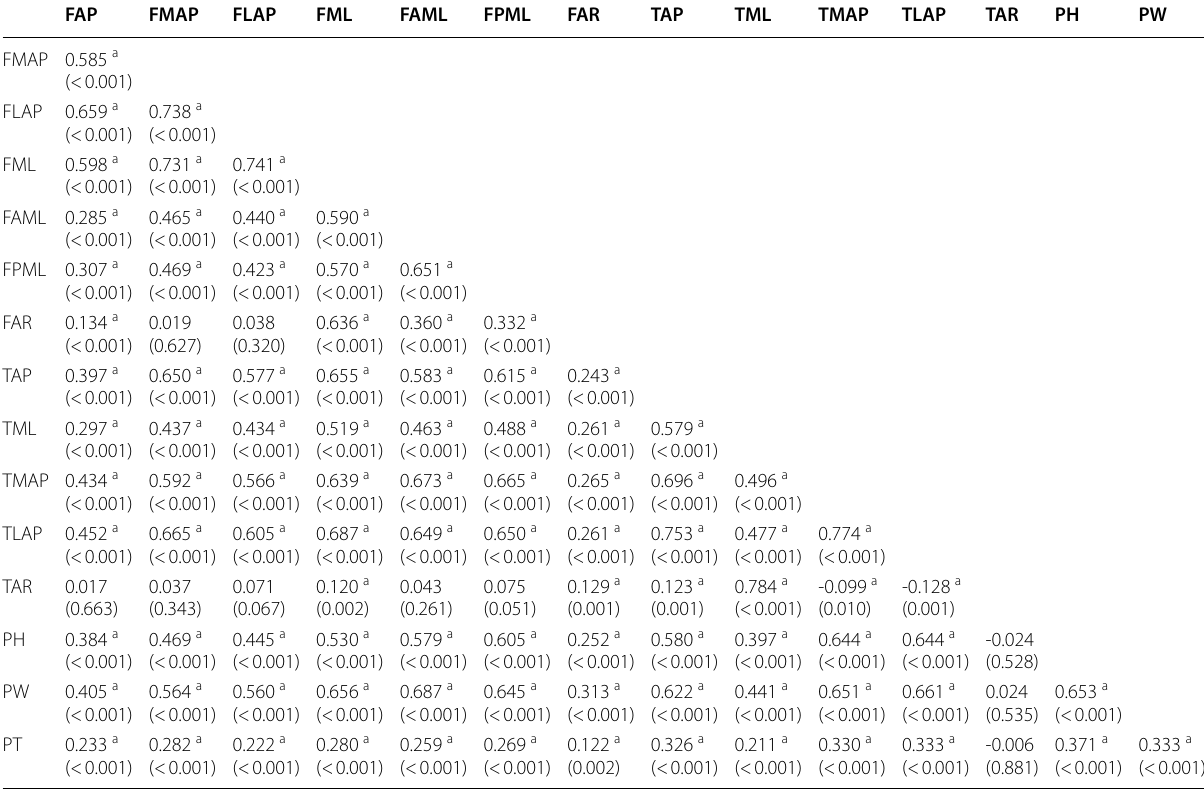
Table 13 Correlation of the knee morphometric parameters ( n